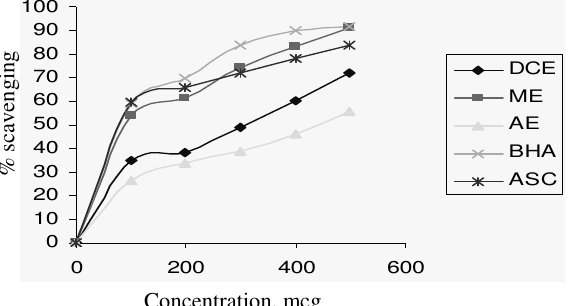
Figure 2. Reducing power of different extracts of Andrographis stenophylla.